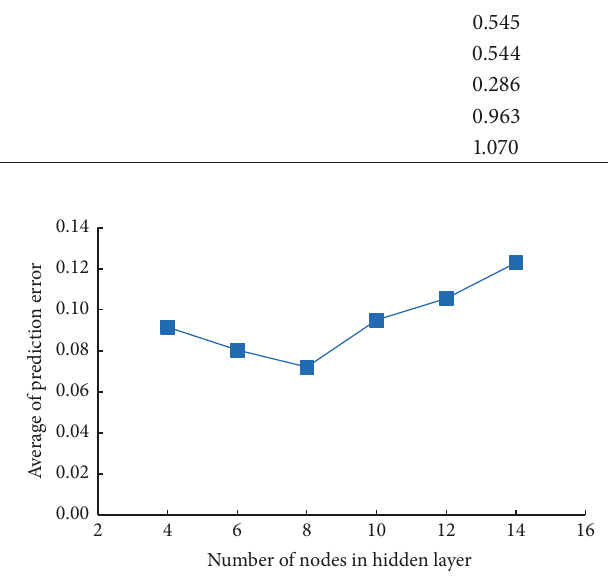
Figure 4: Relationship between neuron node number and average prediction